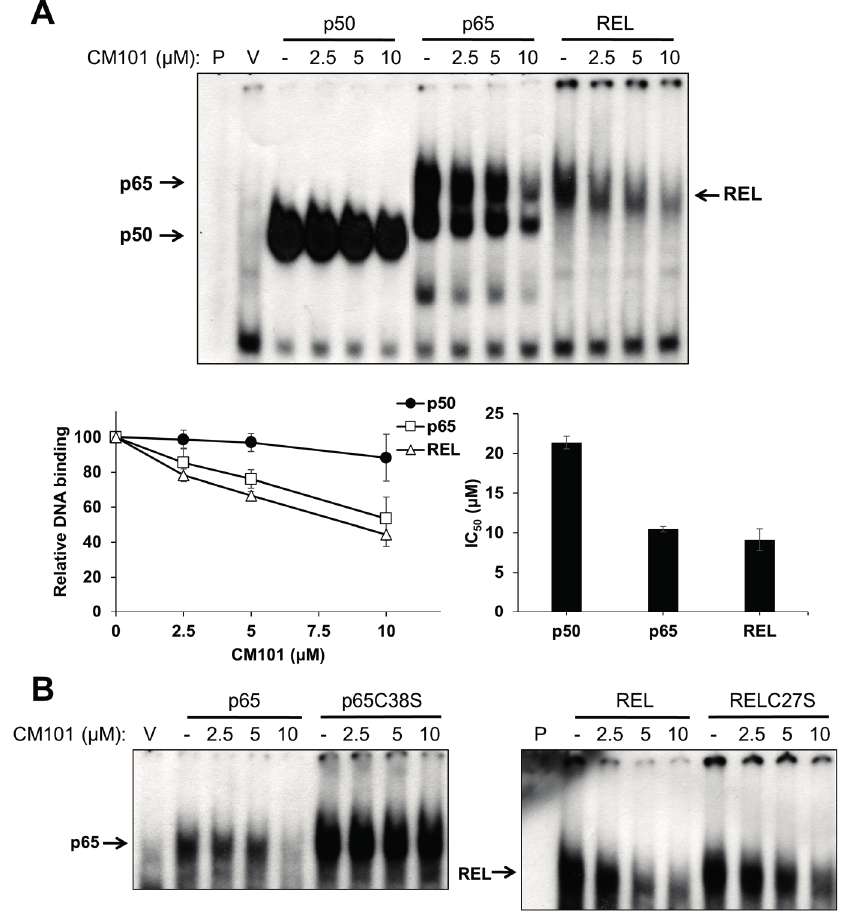
Figure 2. CM101 selectively inhibits REL and p65 but not p50 through covalent modification of cysteine residues. ( A ) 293 cells were transfected with expression vectors encoding FLAG-tagged human p50, p65 and REL, or with the empty vector (V). Transfected cells were treated with the indicated concentrations of calafianin monomer (CM101) for 2 h, extracts were made, and analyzed by EMSA with a κ B-site probe. EMSA bands were detected by phosphorimaging and quantified. IC 50 values were determined by plotting the band intensities at each concentration of CM101, using the control (no CM101) band intensity as 100%. All samples were treated with up to 20 µM CM101 (not shown), which was required to calculate the IC 50 value for p50. Error bars indicate standard errors (three independent experiments); ( B ) 293 cells transfected with expression vectors encoding p65, p65C38S, REL or RELC27S were treated with CM101 and analyzed by EMSA as in (A). P, EMSA lane containing the probe